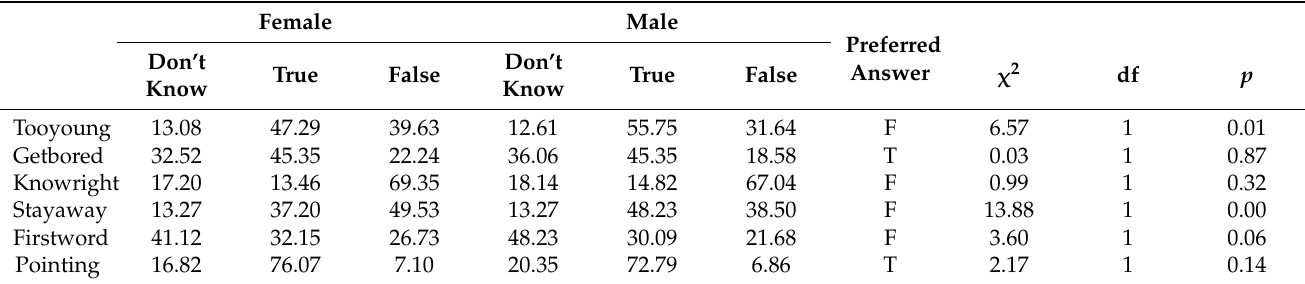
Table 6. Percentage of participants’ responses to questions about their knowledge of child develop- ment by